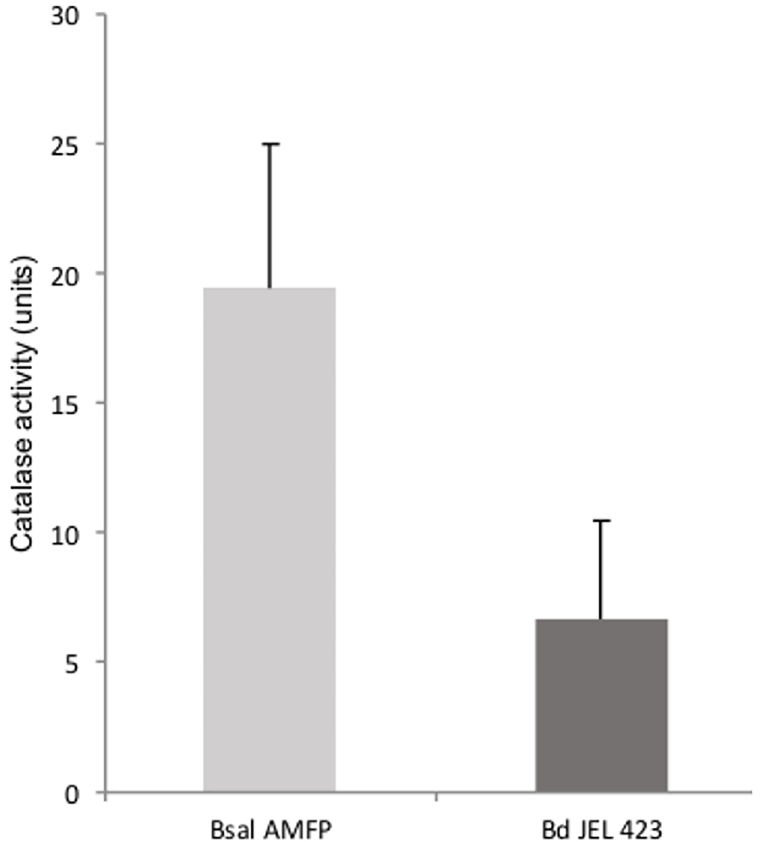
Fig 3. Catalaseactivity of Bsal isolate AMFP and Bd isolate JEL 423. Mean values are shown (n = 3). Error bars represent the